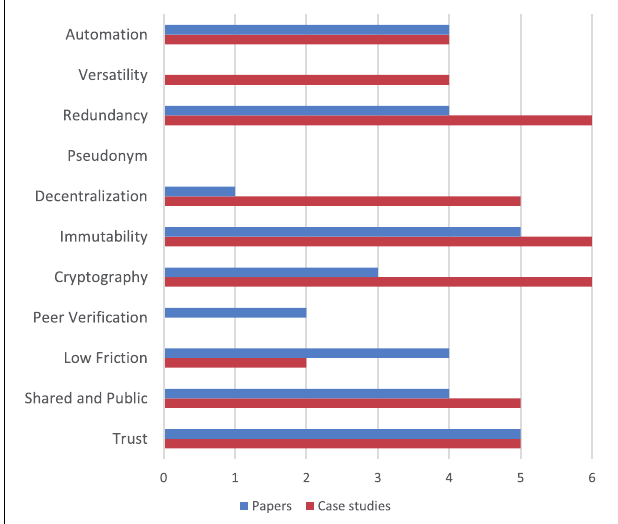
FIGURE 3 | Comparison of blockchain characteristic from literature and case study